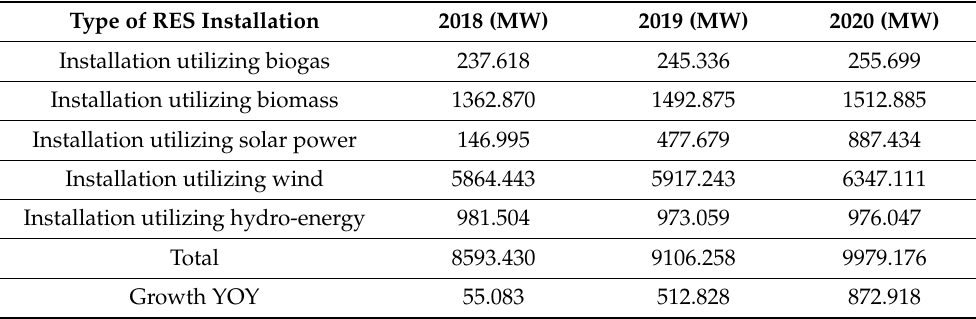
Table 2. Installed power of renewable energy sources in Poland in the years